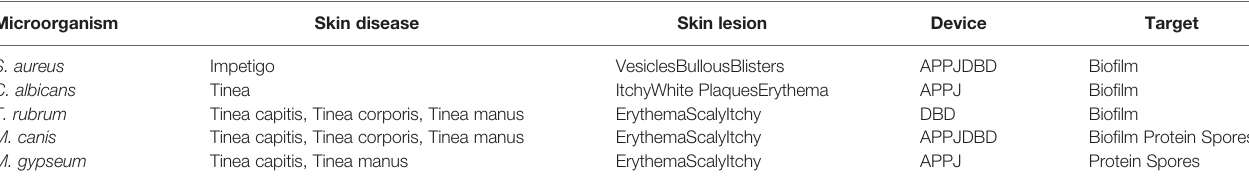
TABLE 2 | The inactivation of CAP for the main skin pathogenic microorganisms.